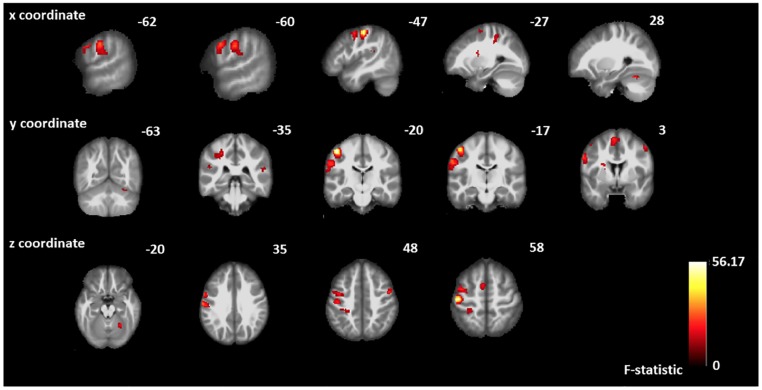
The main effect of velocity stimuli.The main effect of velocity from 20 neurotypical subjects combining 3 different velocities stimulus (5 cm/s, 25 cm/s, and 65 cm/s). Color-coded evoked BOLD responses at each row indicate brain regions (sagittal, coronal and axial view) with high F-values. Most of the BOLD responses in Table 1 are represented in this figure.